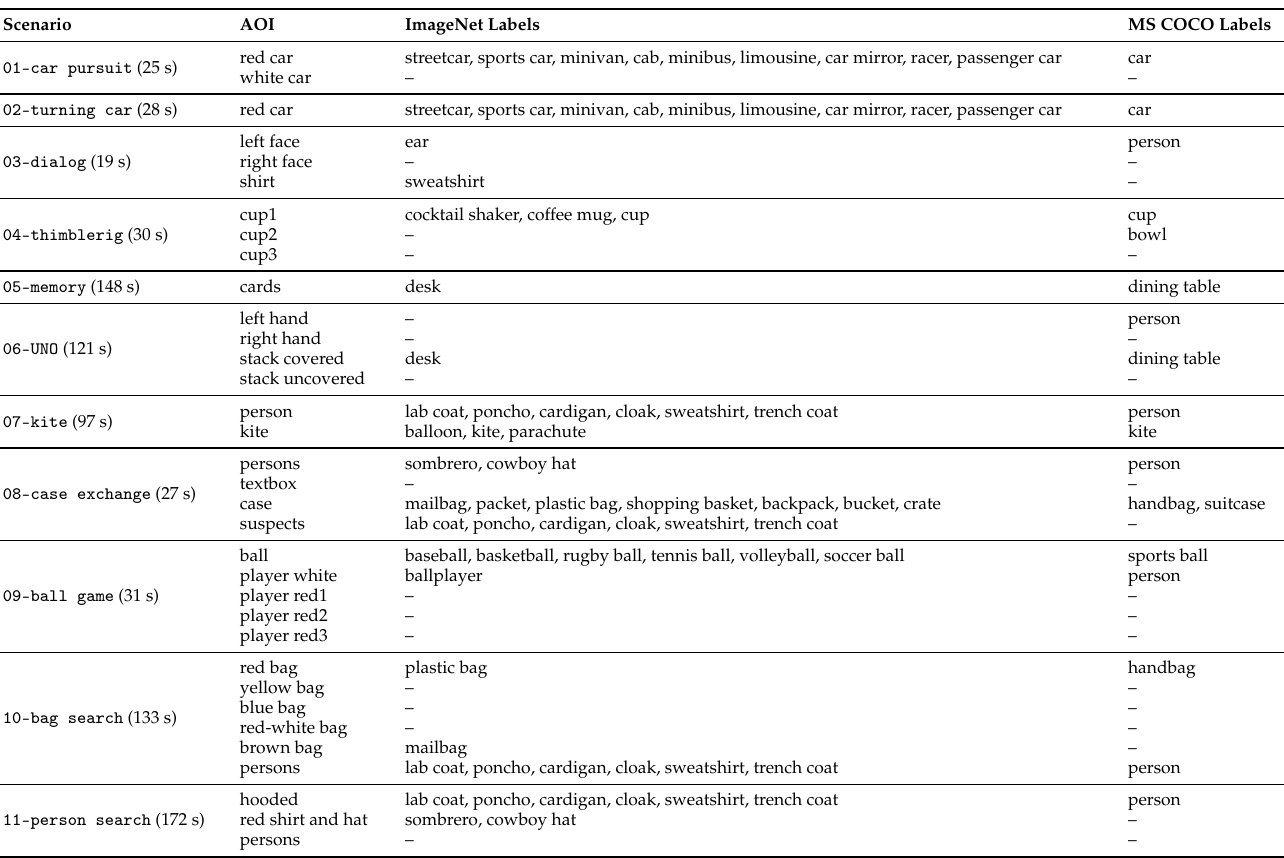
Table 1. Overview of scenarios and AOIs in the VISUS dataset and the corresponding mappings of class labels to AOIs. Class labels originate from ImageNet in case of IC methods and from MS COCO in case of OD